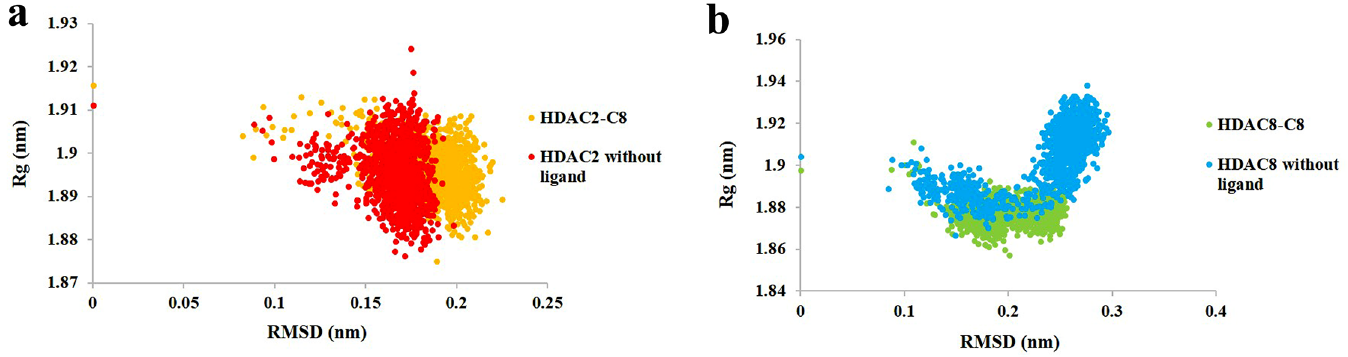
Fig 12. Radius of gyration (Rg) analysis for 12 ns MD simulation. (a) Rg/RMSD plot for HDAC2-C8 complex (yellow) and HDAC2 without ligand (red). (b) Rg/RMSD for HDAC8-C8 complex (green) and HDAC8 without ligand (blue).